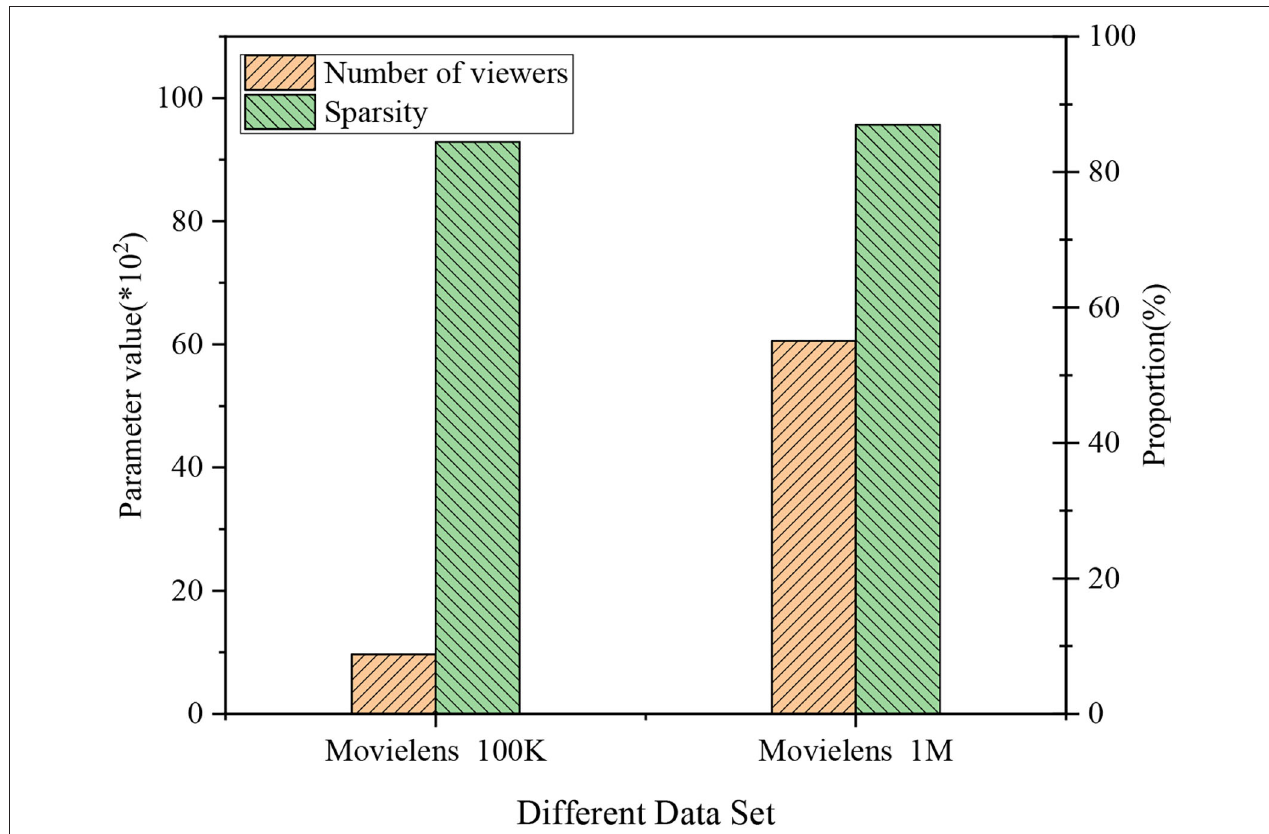
FIGURE 6 | Data histogram of different data sets. *Indicates the size of the parameter value multiplied by 100.